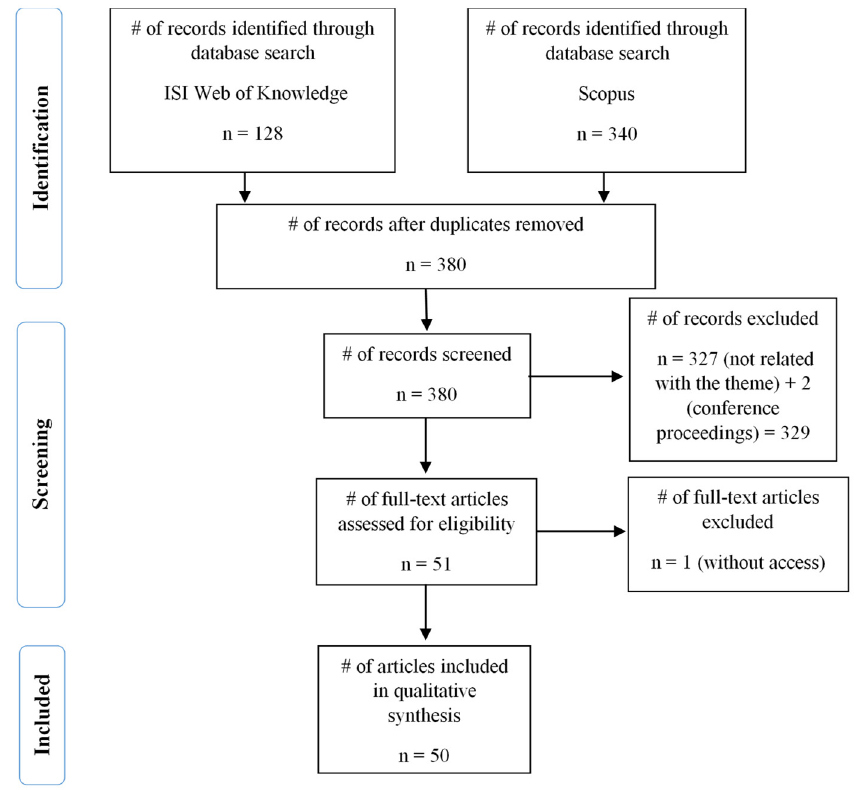
Figure 1. PRISMA 2020 diagram. Adapted from Page et al. (2021).